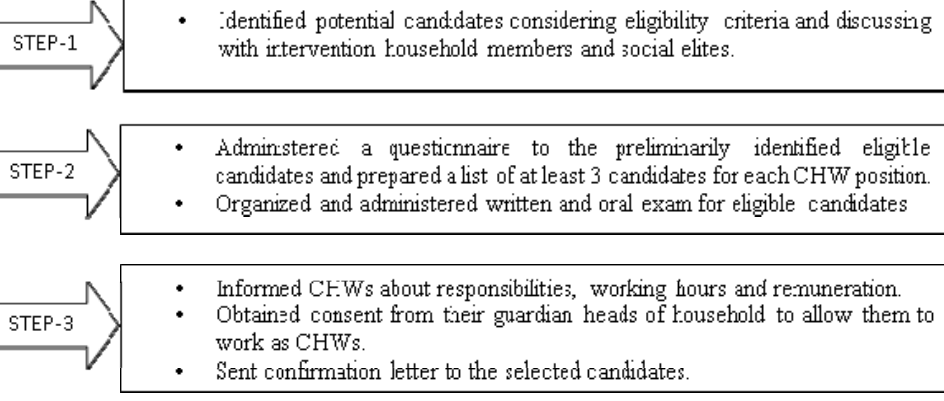
Figure 1. CHW recruitment process by intervention delivery study team.